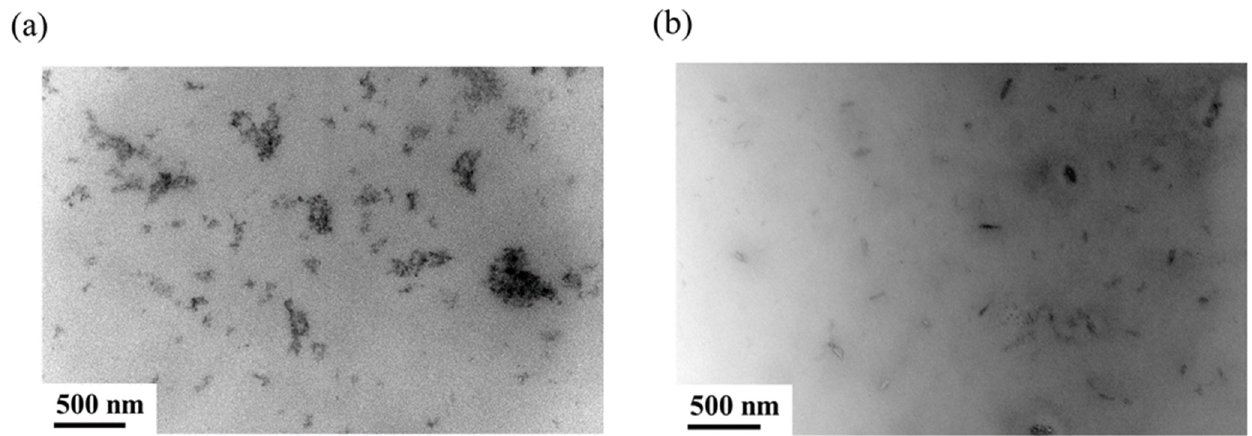
Figure 7. TEM images of 3 wt% ( a ) PBAT-40/CNC and ( b ) g-PBAT-40/CNC